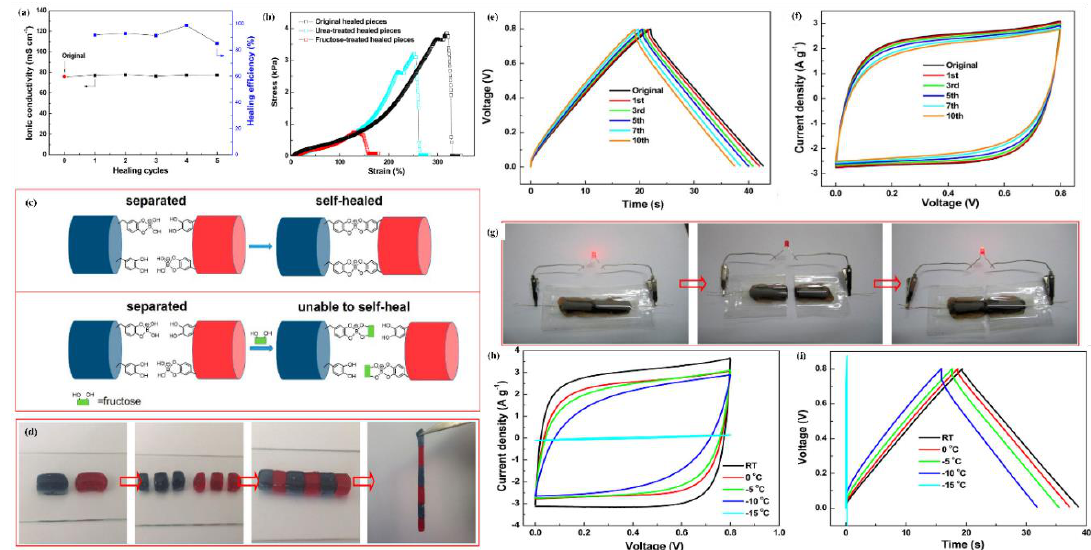
Figure 23. ( a ) Mechanical healing efficiency and ionic conductivity of the electrolyte after multiple cut/healing cycles. ( b ) Effect of urea and fructose treatments on the mechanical properties of the healed pieces. ( c ) Illustration of the self-healing mechanism of the electrolyte. ( d ) Optical images of self-healed hydrogel electrolyte. ( e ) GCD profiles at 1.0 A g –1 ( f ) CVs at 100 mV s –1 , ( g ) Four capacitors were connected in series to light up LED bulb through cut/healing operations. ( h ) Electrochemical performances of the capacitor at low temperature, CVs at 100 mV s –1 , ( i ) GCD profiles at 1.0 A g –1 [197] .